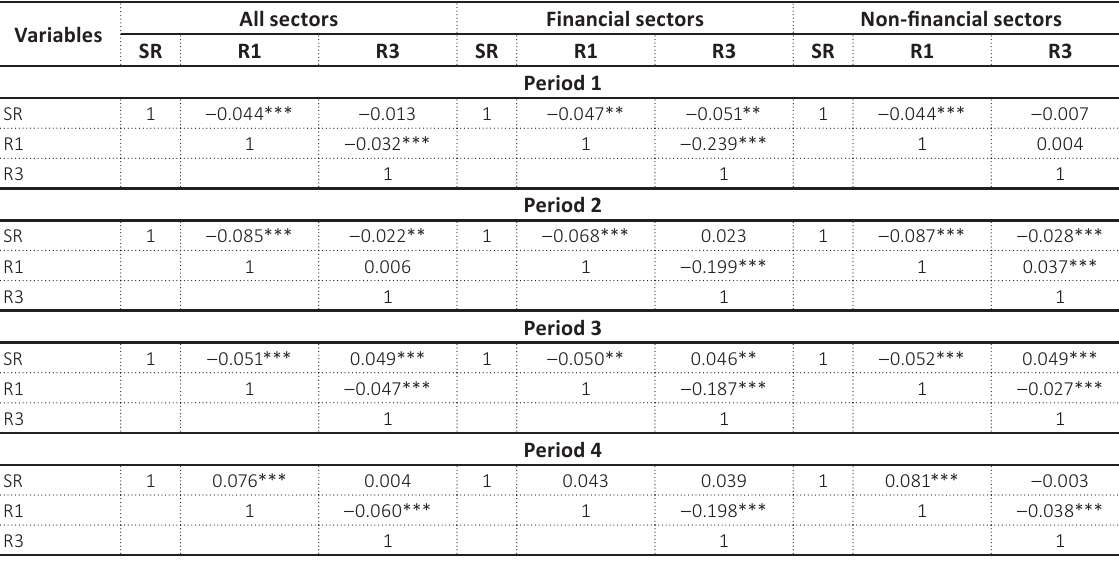
Table 2. Correlation analysis (systematic risk is stock beta)